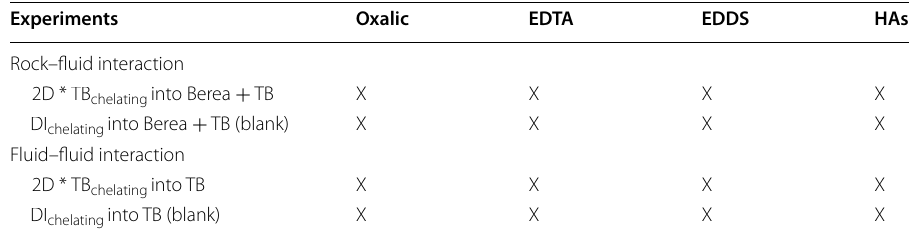
Table 3 Overview of microcalorimetry evaluation Experiments Oxalic EDTA EDDS HAs Rock–fluid